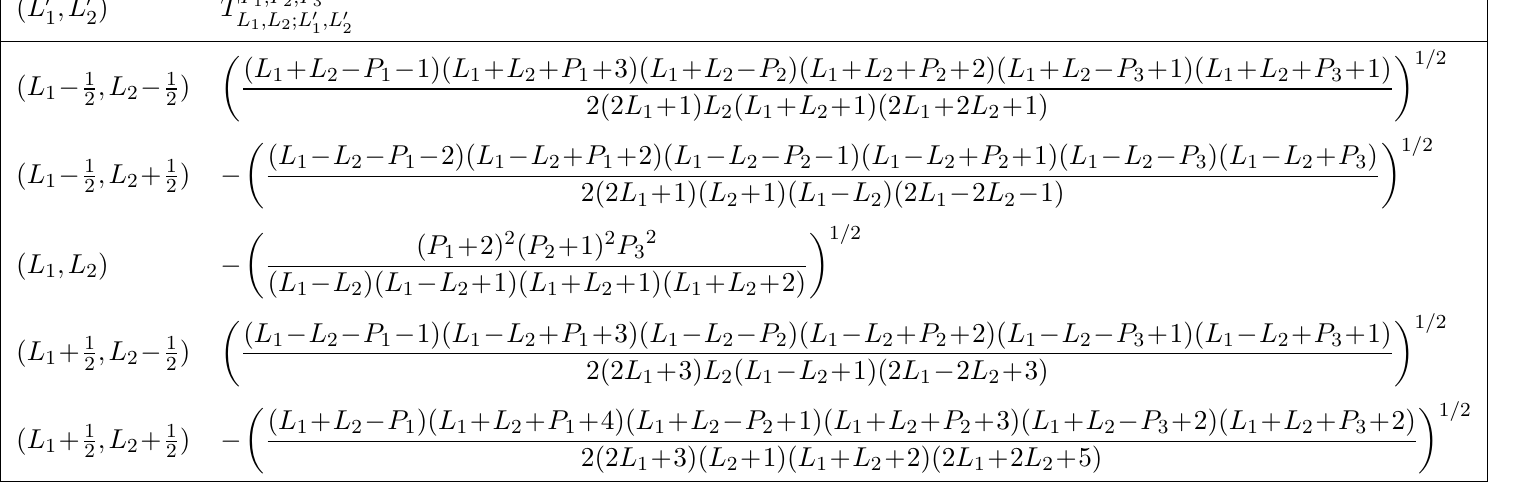
Table 8 . Reduced matrix elements appearing in